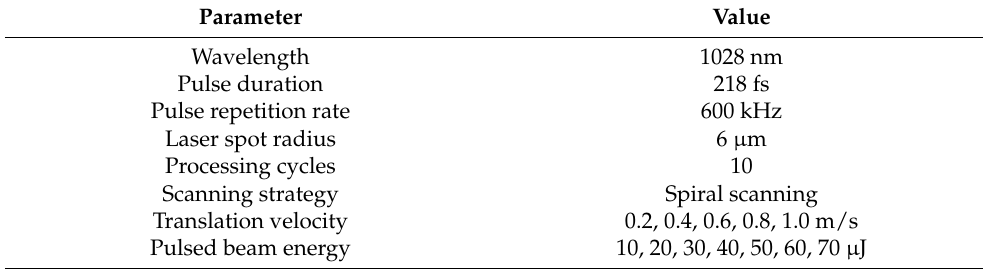
Figure 1. The setup of the femtosecond laser processing system for SiC surface treatment. The processing parameters for the femtosecond laser to obtain micropillars on a SiC substrate are listed in Table 1. A focused spot radius of 6 µ m in the laser beam and a laser pulse repetition rate of 600 kHz were chosen to process the workpiece of SiC via 10 spiral scanning cycles. The laser processing parameters were scheduled from the combination of different laser pulsed beam energies in the range of 10–70 µ J and laser translation speeds varying between 0.2 m/s and 1.0 m/s. Table 1. The processing parameters with the femtosecond laser.